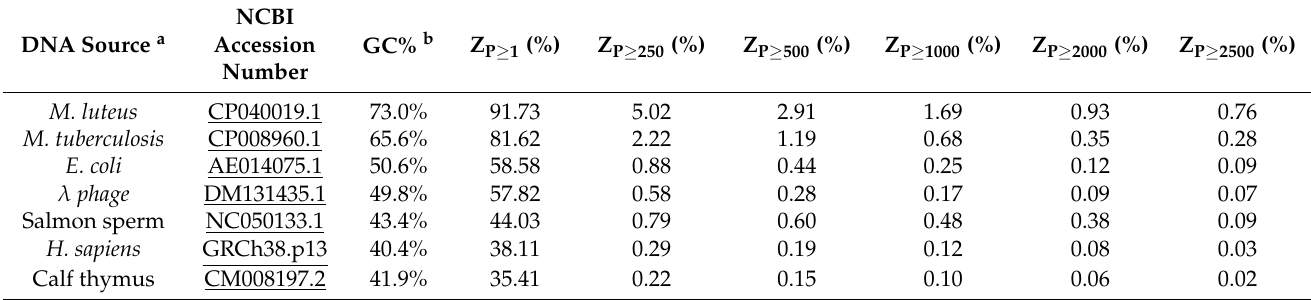
Table 1. DNA sources and